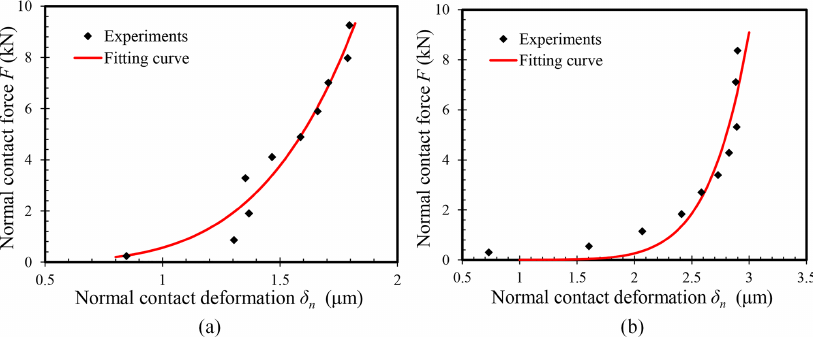
Figure 13. Experimental results and fitting curves of the relationship between normal force and deformation. (a) Turning specimens and (b) milling specimens.